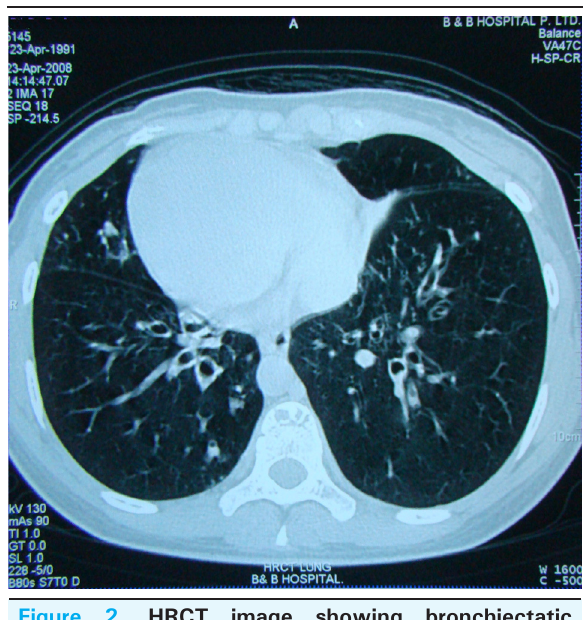
figure 2. HRct image showing bronchiectatic changes Computed tomography (CT) scan of the paranasal sinuses showed diffuse hypodense mucosal thickening involving all the paranasal sinuses with sparing of few ethmoidal cells (Figure 3). Air fluid levels were noted in bilateral maxillary sinuses and deviation of nasal septum over the left side with hypertrophy of middle and inferior turbinates. Bilateral osteomeatal complexes were obliterated due to mucosal thickening.